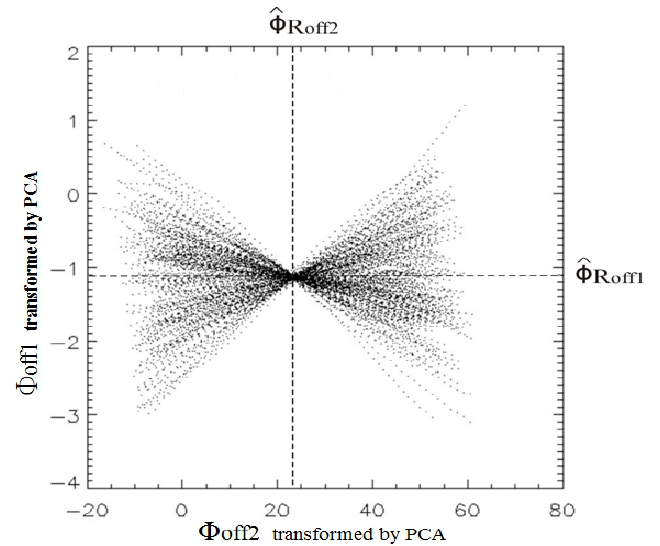
Figure 8. Example of the CPOFs transformed by